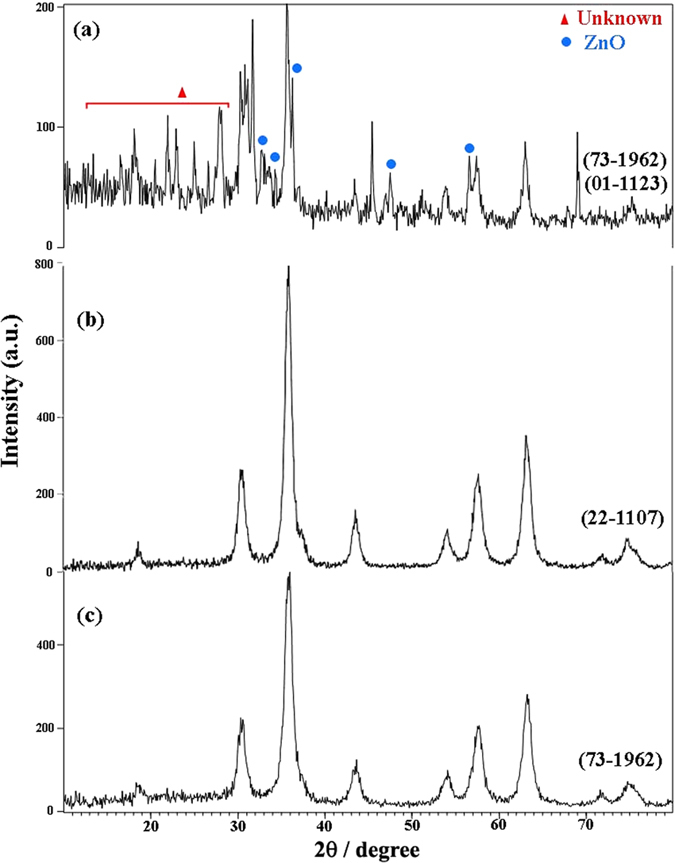
Photocatalytic activities of ZnCr2O4 nanoparticles (sample 4).